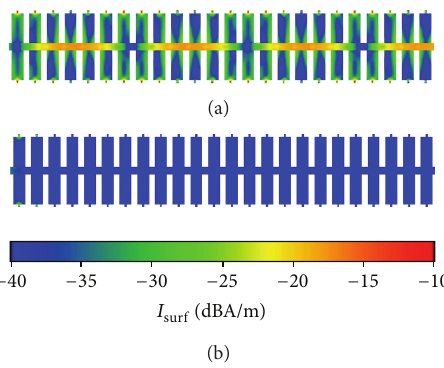
Figure 4: 24-element array: surface current distribution obtained by the SFX method at 𝑓 = 2.6 GHz (a), 𝑓 = 3.9 GHz (b).